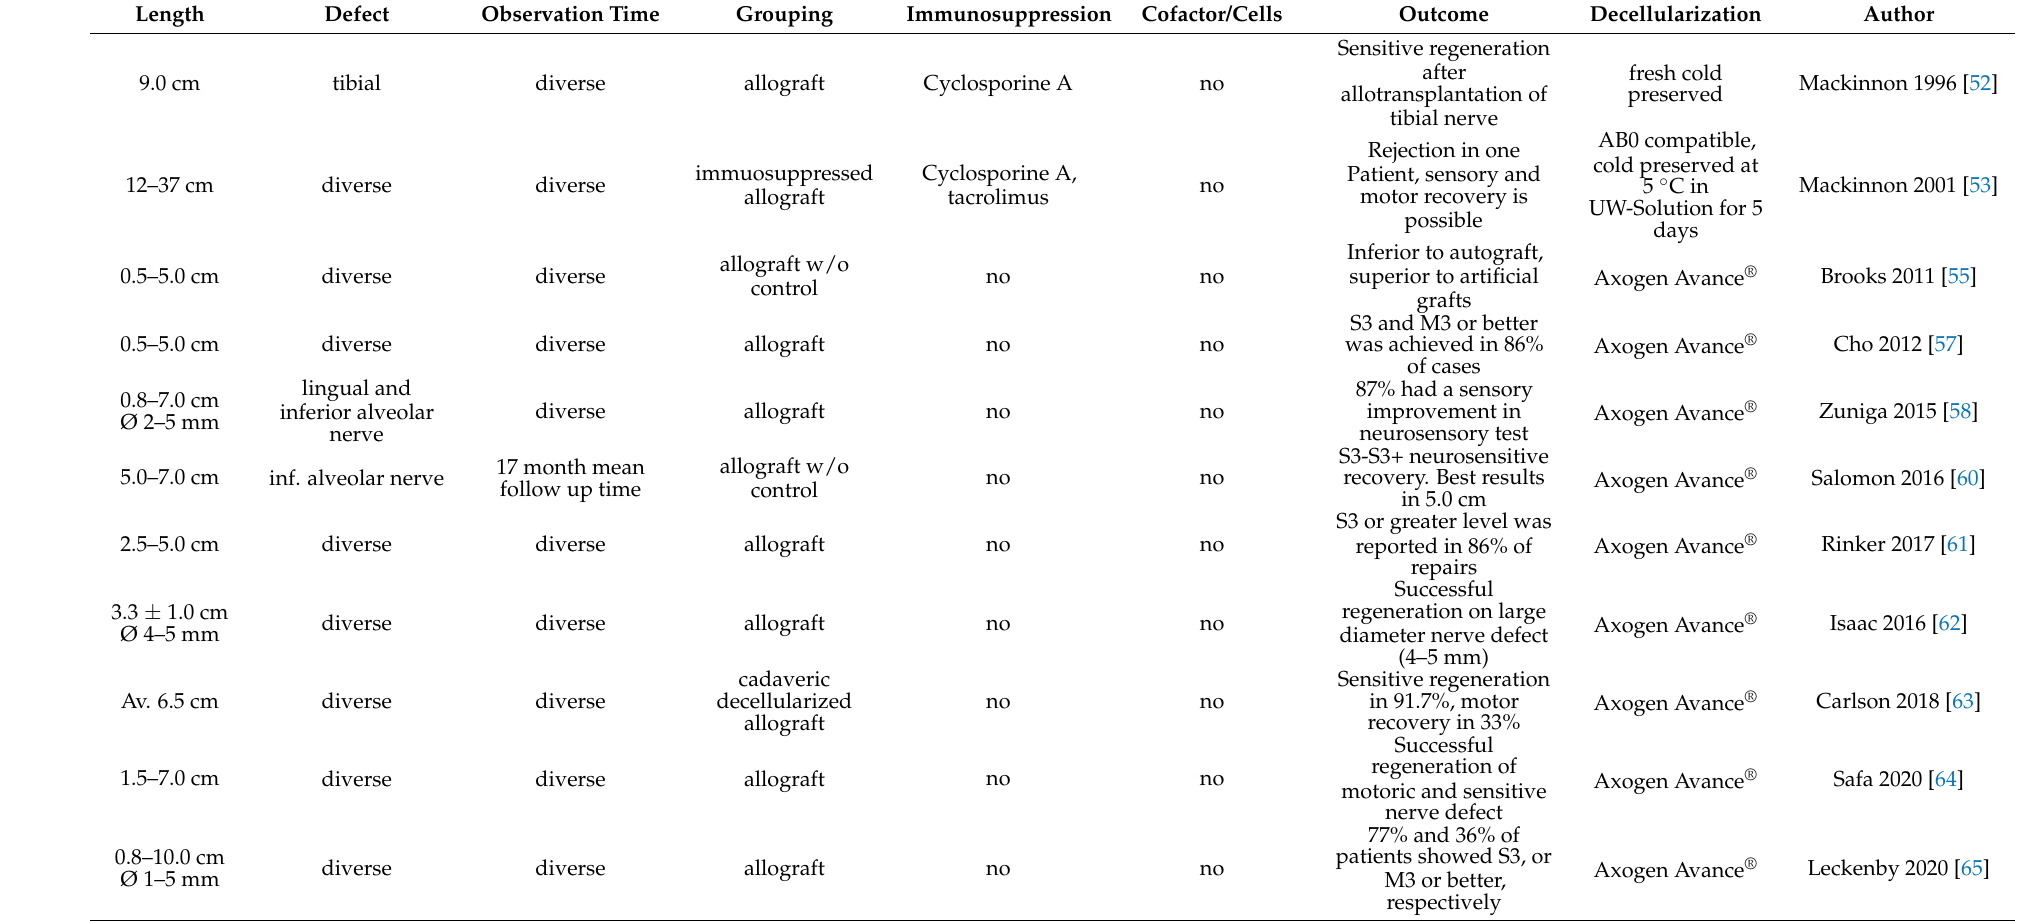
Table 2. Clinical use of cadaveric